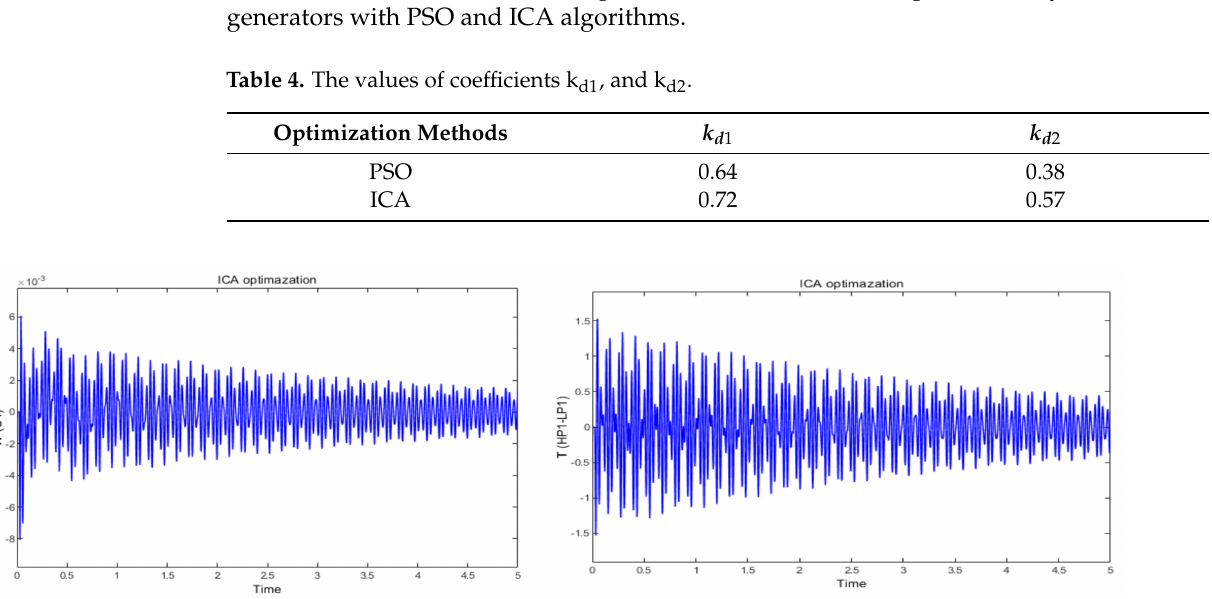
Figure 15. Damping of SSR with ICA method (synchronous generations and, turbine